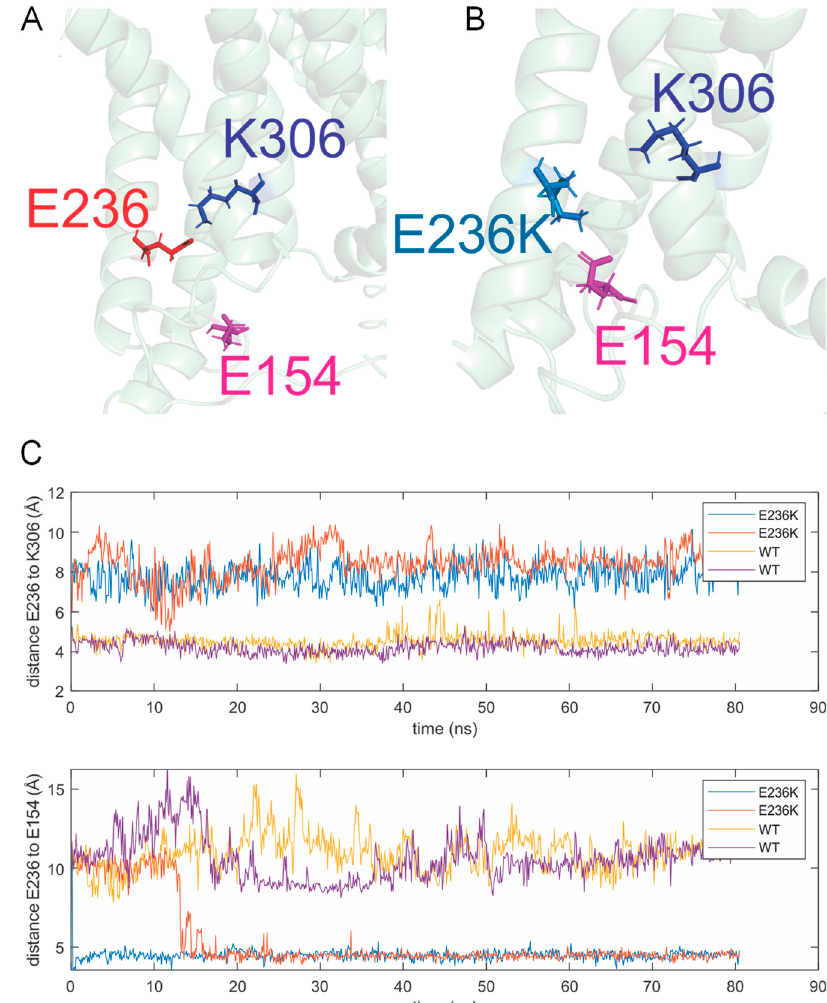
Figure 6. Three-dimensional (3D) protein structure of the Kv1.2 channel shown as a ribbon model and localization of the E236K missense variant. Close-up views of the Kv1.2 WT ( A ) and E236K subunit ( B ). The residues E236, E236K, K306 and E154 are shown in stick representation. Whereas E236 (red) in the WT subunit remains interacting with the 5th gating charge in S4 during the simulation, K306 (blue), the E236K (cyan) does no longer interact with the charges in S4 but rather with E154 (magenta) in the T1-S1 linker close to S1. ( C ) Distances between the Kv1.2 WT or E236K and K306 (S4; upper panel) or E154 (T1-S1; lower panel). The distance to the S4 gating charge is much larger for the mutants, and they flip within the first 15 ns to the E154.